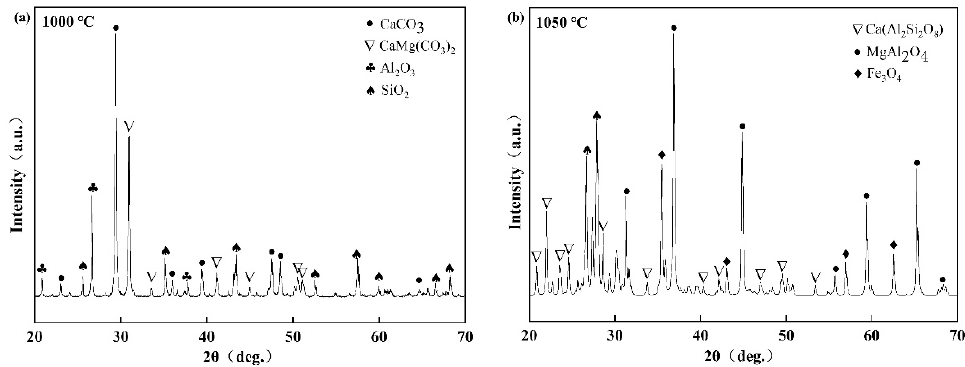
Figure 6. XRD patterns of ceramsite at 1000 °C ( a ) and 1050 °C ( b ) .